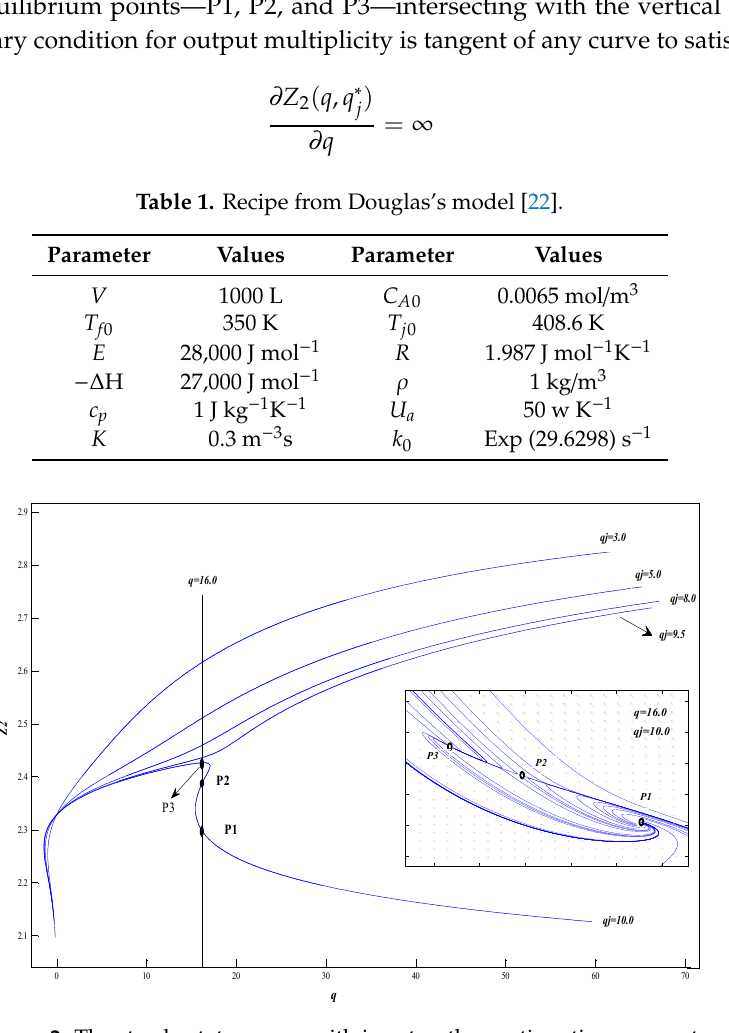
Table 1. Recipe from Douglas’s model [22].